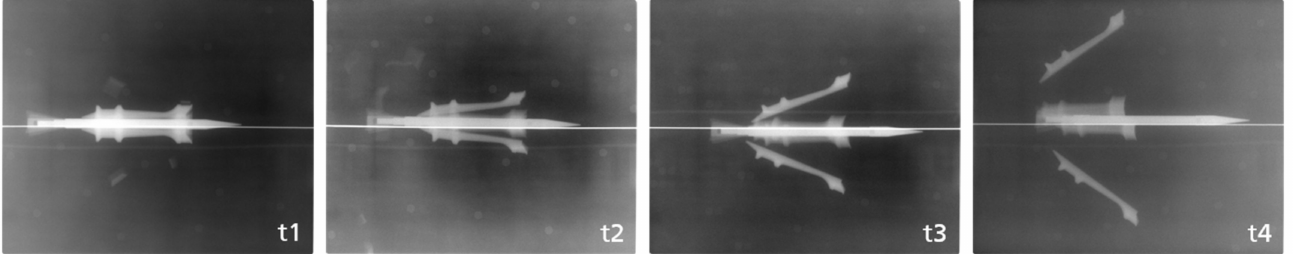
Figure 2. Example of the X-ray images for one orientation and all four positions (t1–t4). The first image at the point of time t1 is positioned 500 mm behind the muzzle; hence, t2 is at 1500 mm, t3 at 2500 mm and t4 at 3500